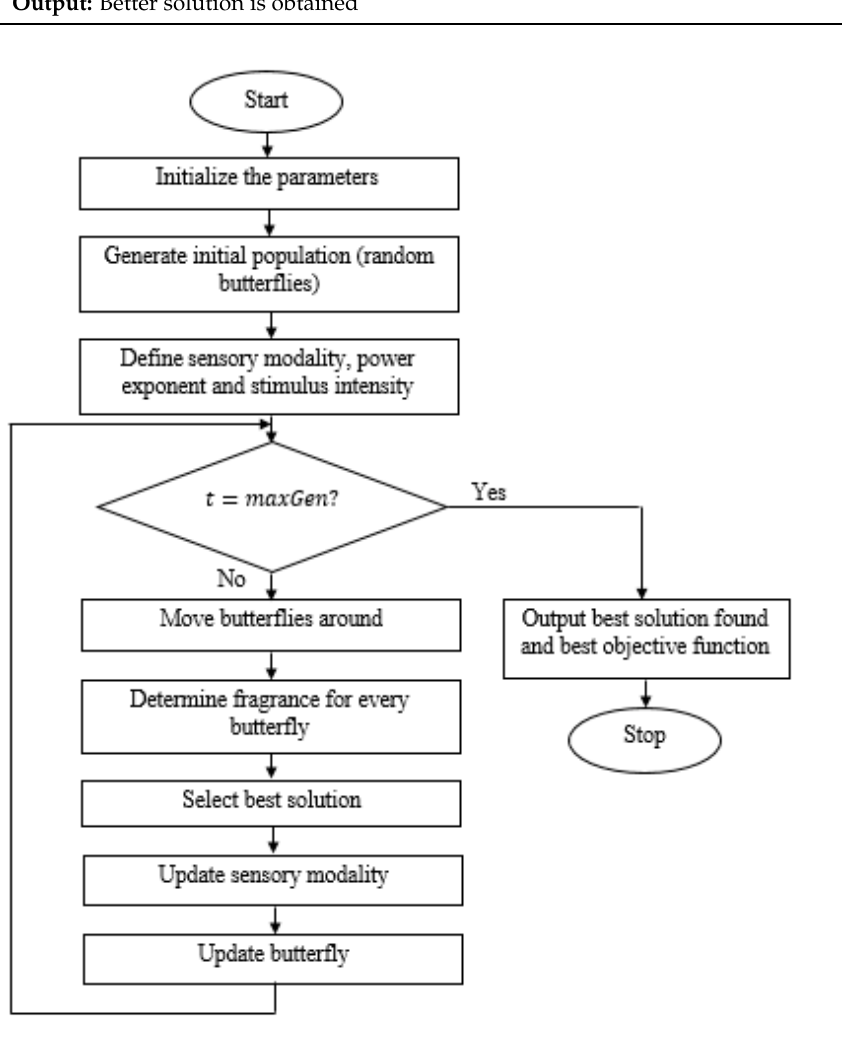
Figure 6. Flowchart of the BOA.